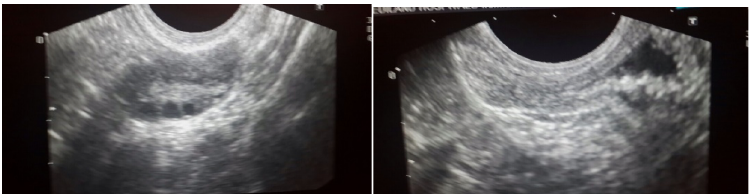
Figure 2. Trans-rectal ultrasound scan showing normal size ovaries and